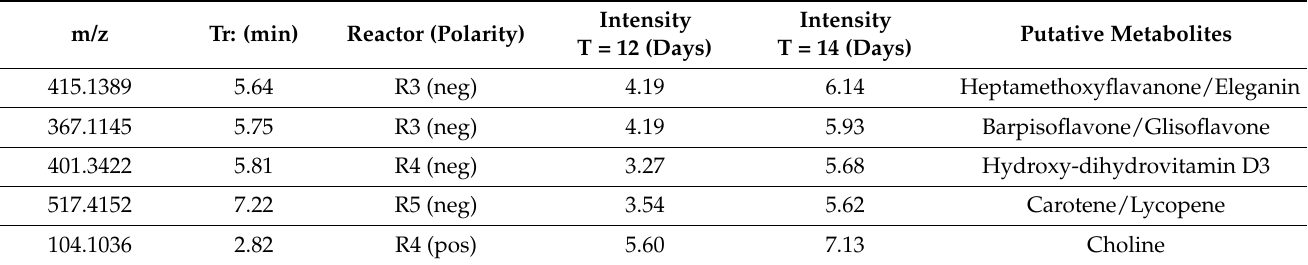
Table 6. Some metabolites whose levels changed in the three reactors.